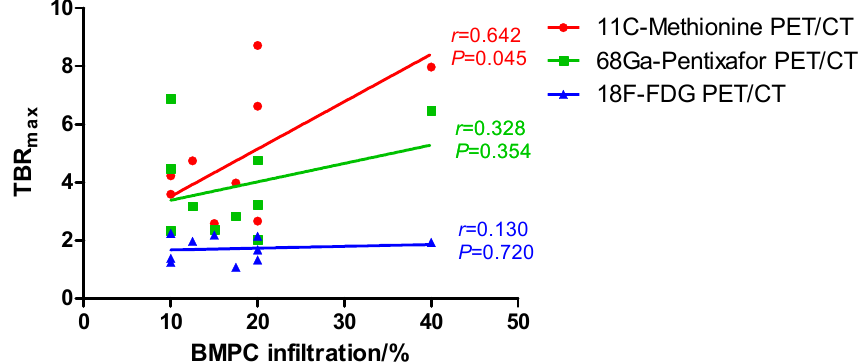
Figure 4. Correlation between bone marrow plasma cell (BMPC) infiltration and maximum target to background ratio (TBR max ) on 11C-Methionine, 68Ga-Pentixafor, and 18F-FDG PET / CT: We observed a significant correlation between BMPC infiltration and TBR max in 11C-Methionine PET / CT (Pearson’s r = 0.642, p = 0.045, red). On 68Ga-Pentixafor (Pearson’s r = 0.328, p = 0.354, green) and 18F-FDG (Pearson’s r = 0.130, p = 0.720, blue) PET / CT, the correlation between TBR max and BMPC infiltration was not significant.